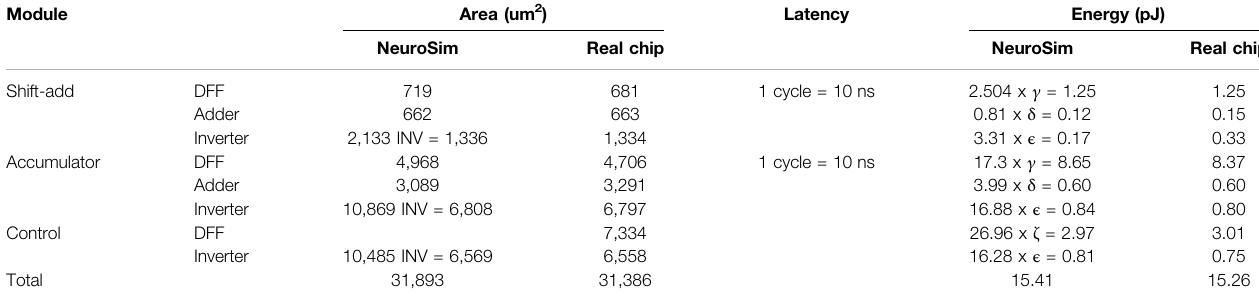
TABLE 5 | Digital modules validation.